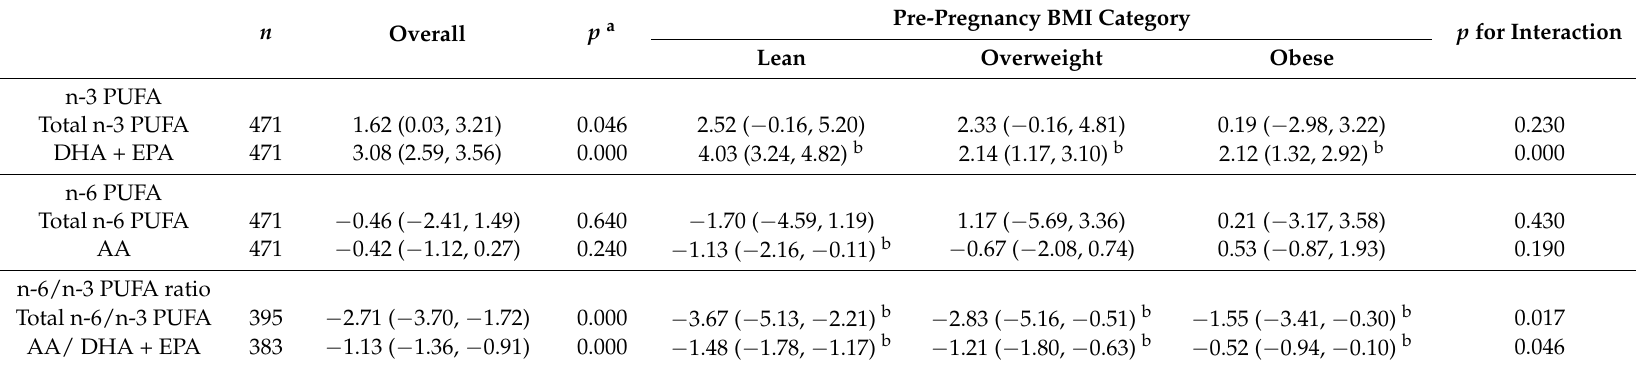
p for Interaction